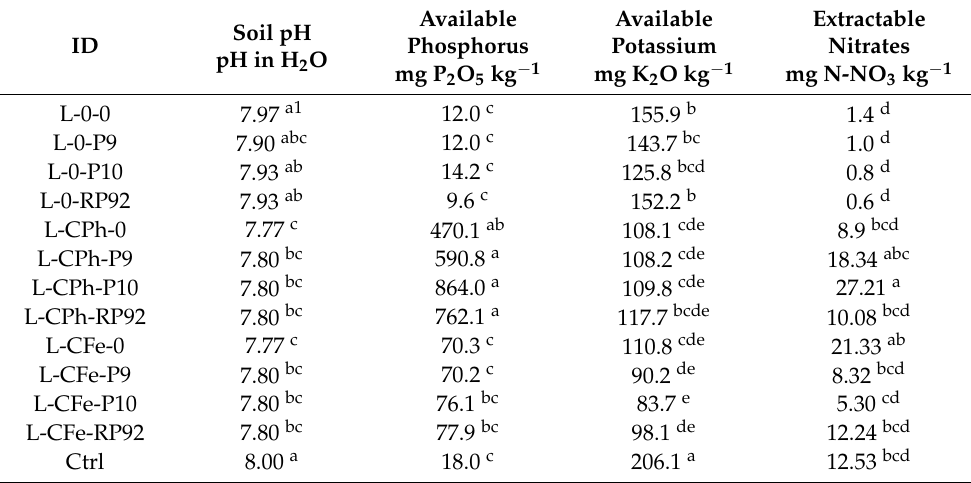
Table 4. Soil parameters as dependent on the remediation